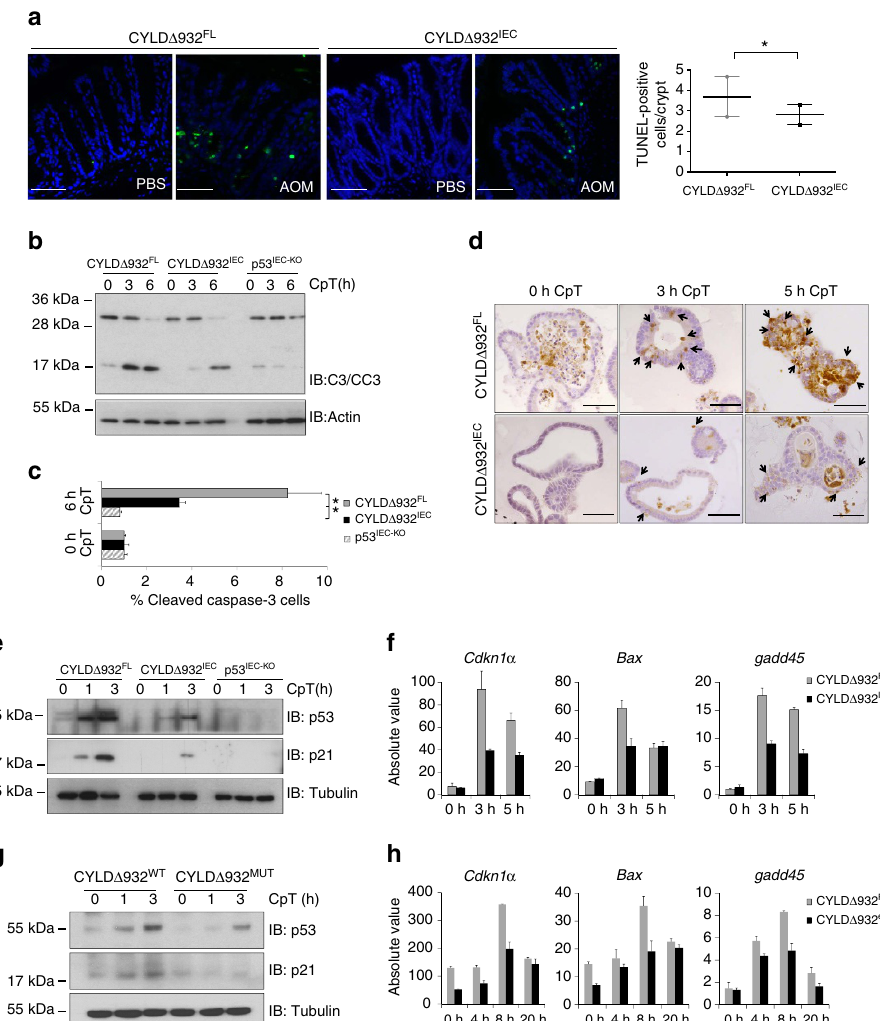
Figure 3 | Impaired DNA damage-induced p53 activation in CYLD D 932 mutant epithelial cells. ( a ) Representative pictures from TUNEL-stained colon sections from the indicated mice 8h after AOM or PBS injection and quantification of TUNEL-positive IECs in colonic crypts. Data shown as mean ± s.e.m. of 150 well-oriented crypts from three animals of each genotype. Statistical significance was determined with Student’s t -test; * P r 0.05. ( b ) Immunoblot analysis for caspase-3 (C3) and cleaved caspase-3 (CC3) in CpT-treated intestinal organoids prepared from the indicated mice. ( c ) FACS quantification of CpT-induced cleaved caspase-3-positive cells in organoids from the indicated mice. Mean ± s.d. of biological triplicates shown. Statistical significance was determined with Student’s t -test ** P r 0.005. One representative out of three independent experiments is shown. ( d ) Immunohistochemical analysis for active caspase-3 in CpT-treated intestinal organoids from the indicated mice. Arrows indicate epithelial cells stained for active caspase 3. Note that the luminal contents of organoids show unspecific staining. Scale bar, 50 m m. ( e – h ) Immunoblot analysis of p53, p21 and tubulin and qRT-PCR analysis of p53 target gene expression in CpT-treated intestinal epithelial organoids ( e,f ) and primary epidermal keratinocytes ( g , h ) prepared from the indicated mouse lines. Graphs in f and h show means ± s.d. of the absolute values of technical duplicates, from one representative out of two independent experiments. qRT-PCR, quantitative real-time